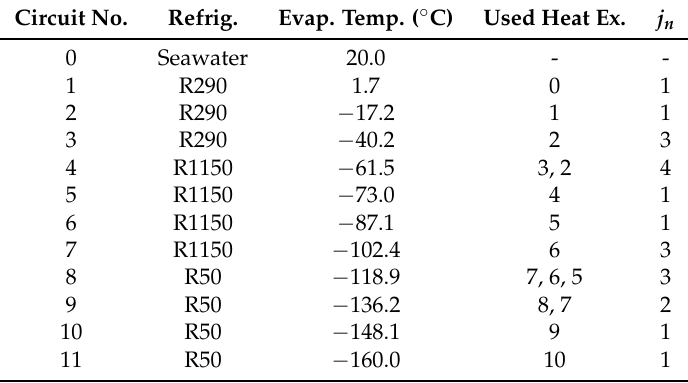
Table 2. Optimized configuration of the 3-4-4-Cascade. Circuit No.